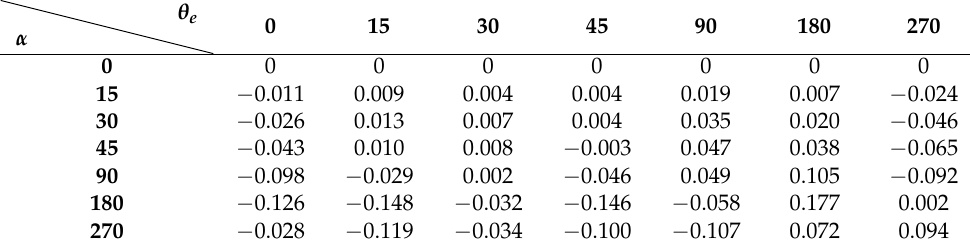
Table 4. Simulation data of the total error (unit: